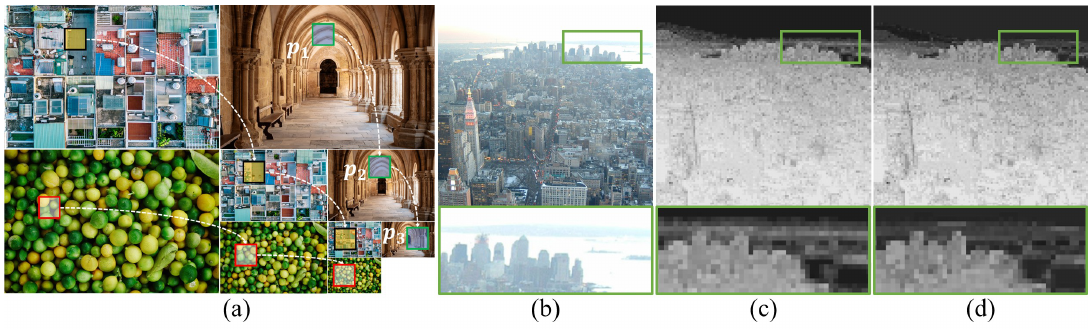
Figure 6. An image pyramid generated using the haze-free images collected from the internet and estimated transmissions using a single in-scale and multiscaled spaces: ( a ) an image pyramid [19], ( b ) an input haze image [16], reproduced with permission from [16], IEEE, 1969 and ( c , d ) comparative results of transmission estimated using random